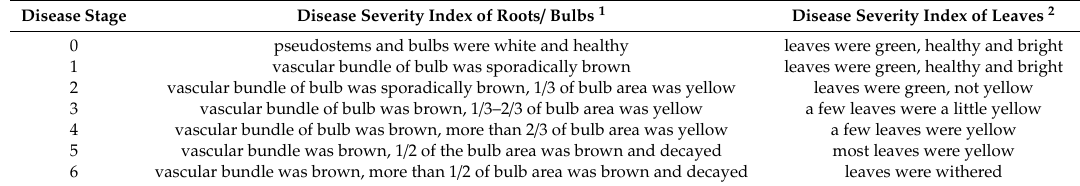
Table 4. Disease index classification